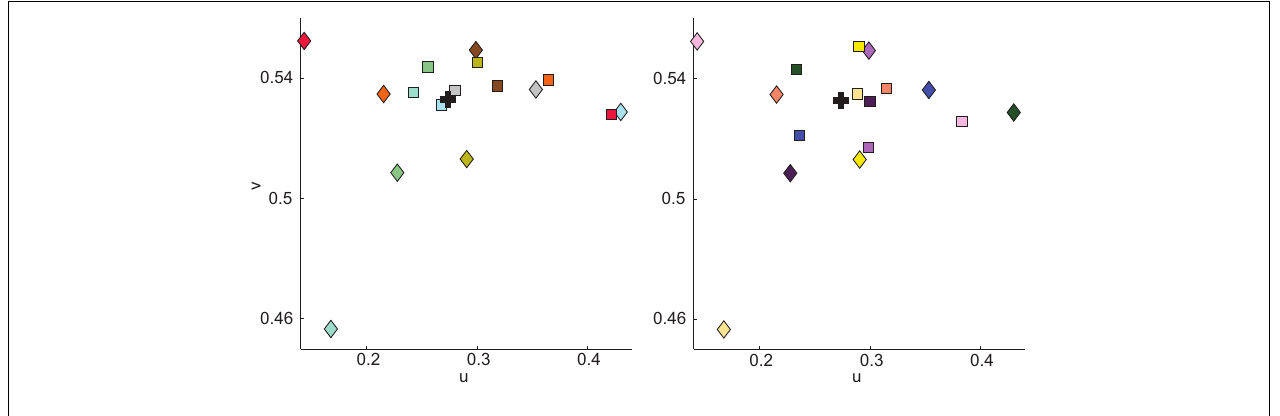
FIGURE 3 | Illustration of cube (squares) and background (diamond) chromaticity as measured in Booth A. Stimuli are divided into panels to aid visualization. Square color indicates the apparent color of the cube; diamond color illustrates the apparent